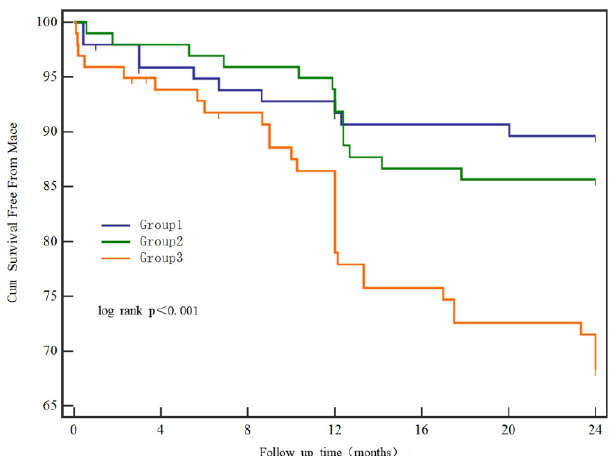
Figure 2. Kaplan–Meier survival analysis for MACE. Patients were divided according to decreasing tertiles of FT3/FT4 ratio (Group 1: FT3/FT4 ≥ 4.3, Group 2: 3.5 ≤ FT3/FT4 < 4.3, Group 3: FT3/FT4 < 3.5). FT3, free triiodothyronine; FT4, free